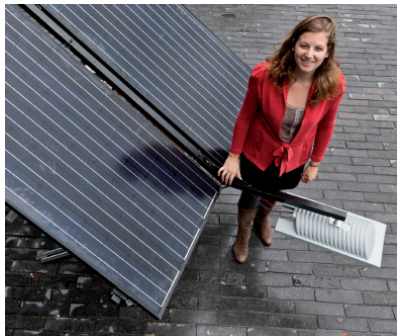
Figure 15. A prototype of set 2 PV cells plus lamp.